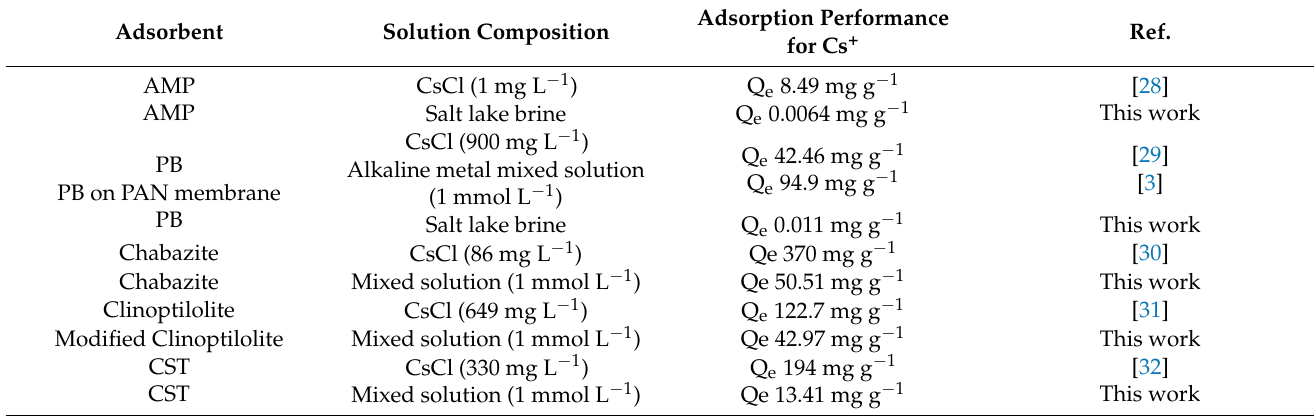
Table 2. Some typical adsorbents for Cs +